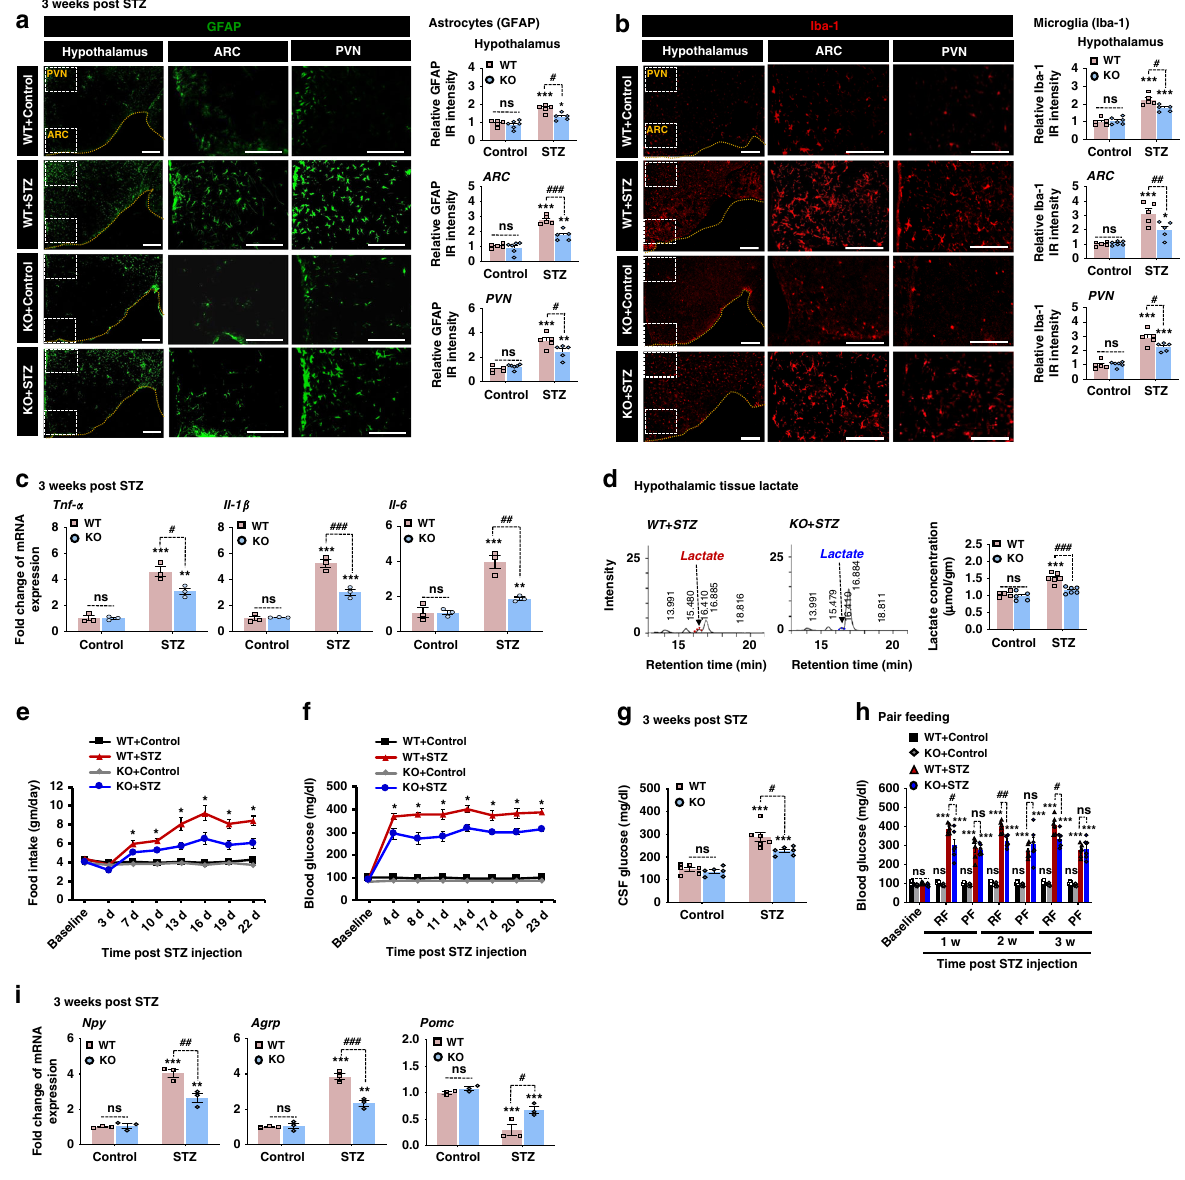
Fig. 2 Pdk2 -de fi ciency attenuates the diabetes-induced increase in proin fl ammatory cytokines, gliosis, lactate level in the hypothalamus, food intake, and blood and CSF glucose levels in mice. GFAP (# p = 0.0101, KO + STZ for hypothalamus; ###p = 0.0003, KO + STZ for ARC; and # p = 0.0192, KO + STZ for PVN) and Iba-1 (# p = 0.0170, KO + STZ for hypothalamus, ## p = 0.0090, KO + STZ for ARC; and # p = 0.0277, KO + STZ for PVN) immuno fl uorescence staining and image analysis were performed using WT and Pdk2 -de fi cient mice at 3 w post-STZ injection ( a , b ).